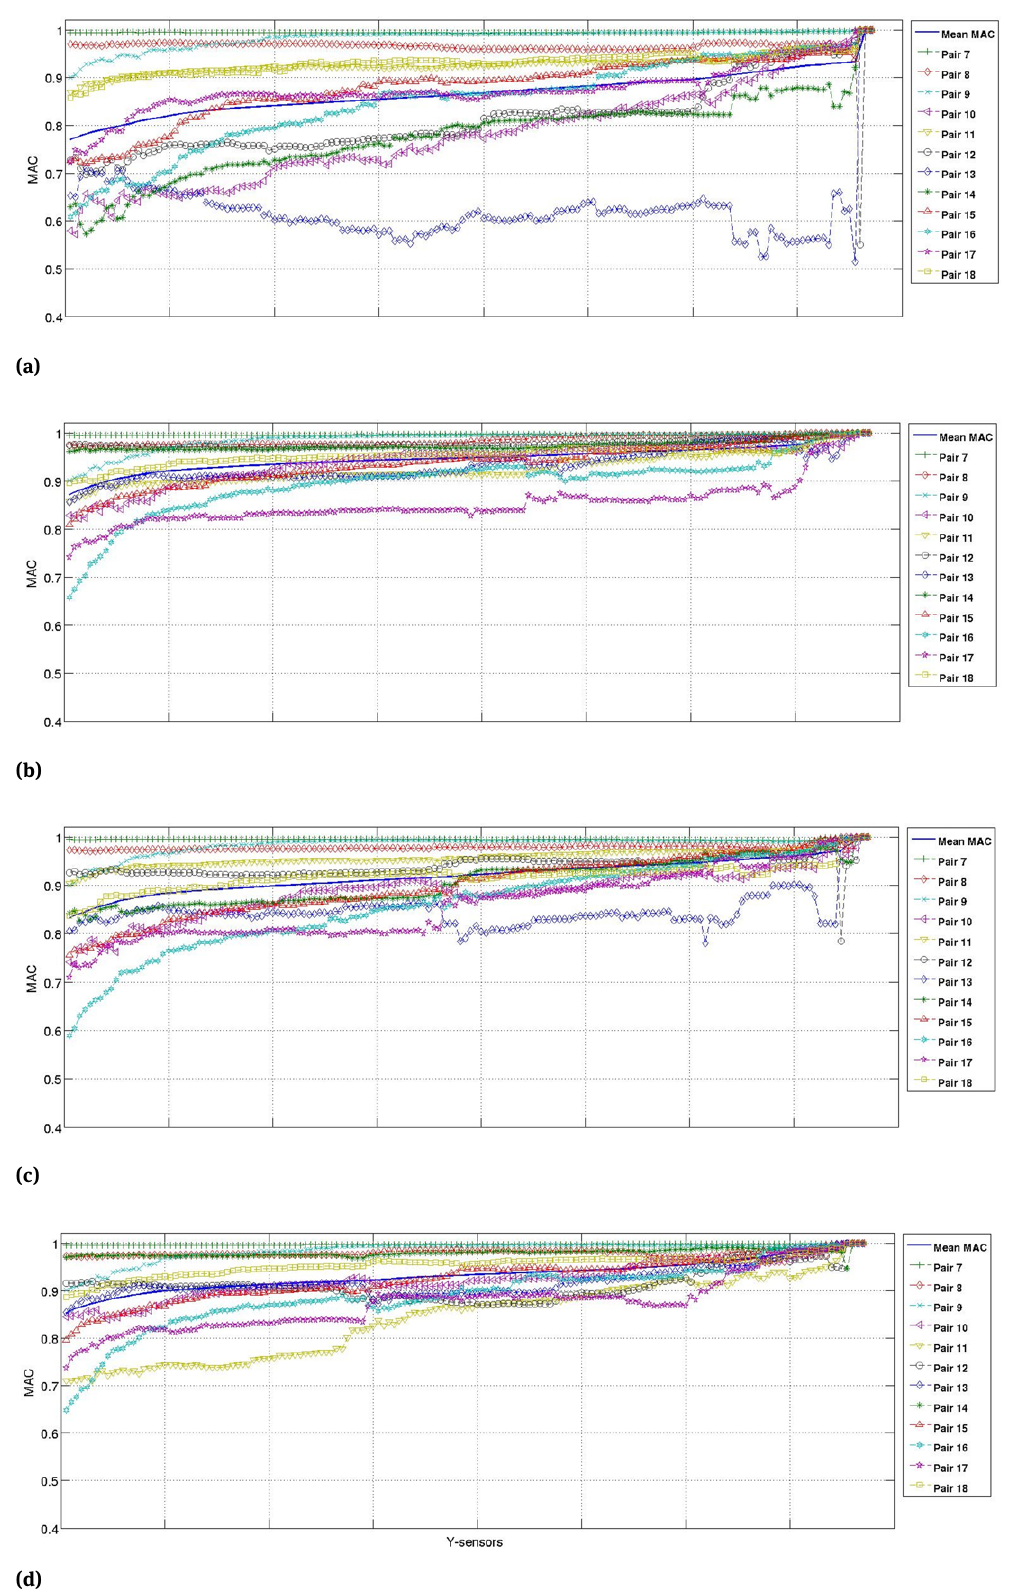
Figure 8: Comparison of MACcos: a) SDtools-Exp (non-updated), b) SDtools-Exp (updated), c) MSC/NASTRAN-Exp (updated), d)